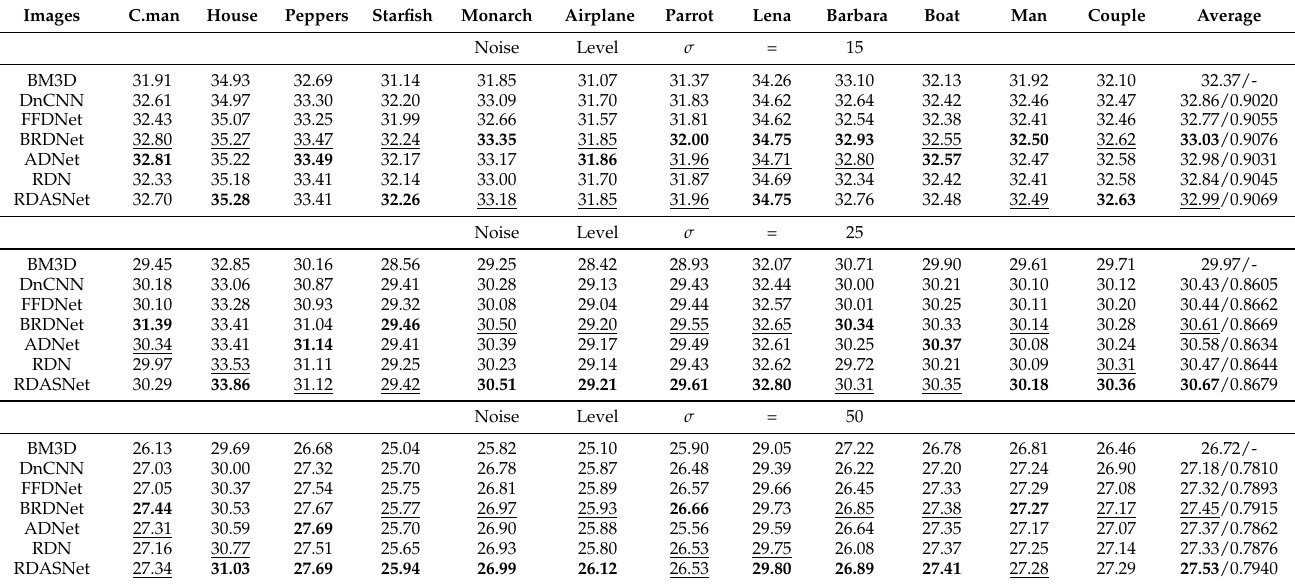
Table 2. PSNR (dB) and SSIM of different methods on the Set12 for different noise levels (i.e., 15, 25, and 50). The best PSNR two results are shown in bold and underlined, respectively.